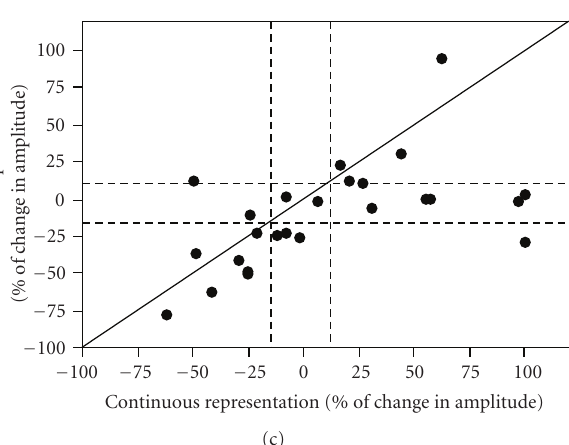
Figure 4: Individual neuron data. (a) Continuous pathway pairing. Change in PSP amplitude (expressed as percent of the baseline PSP amplitude) for continuous representation pathway plotted against discontinuous representation pathway for each cell that received continuous pathway pairing. Solid diagonal line depicts slope of one. Dashed lines depict 15% above and below no change (100%). (b) Discontinuous pathway pairing. Change in PSP amplitude (expressed as percent of the baseline PSP amplitude) for continuous representation pathway plotted against discontinuous representation pathway for each cell that received discontinuous representation pathway pairing. Conventions are as in (a). (c) Both pathway pairing. Change in PSP amplitude (expressed as percent of the baseline PSP amplitude) for continuous representation plotted against discontinuous representation pathway for each cell that received both pathway pairing. Conventions are as in